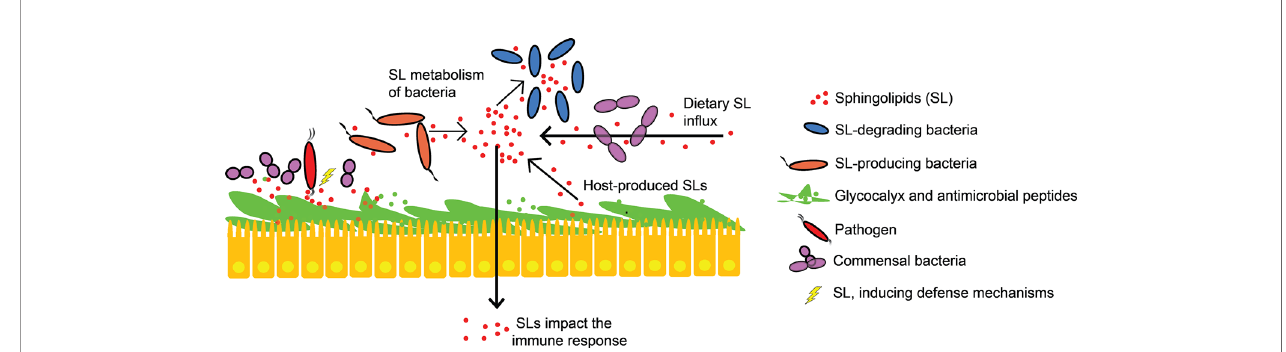
FIGURE 4 | Sphingolipids in host-microbial interactions. Epithelial cells that produce various antimicrobial peptides and secrete mucin (glycocalyx) prevent microbial invasion. SLs alter intestinal mucus function, compete with commensals for epithelial binding sites and induce defense mechanisms against pathogenic bacteria. Intestinal SL levels are not only in fl uenced by diet and endogenous SL-production, but also by SL-producing and SL-degrading bacteria. Bacterial and host SLs are structurally similar. They mediate speci fi c host immune responses and interact with